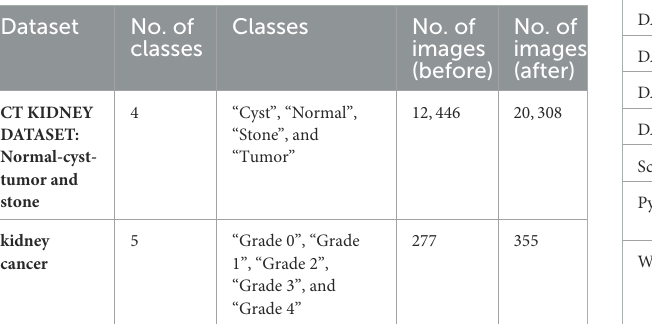
TABLE 5 The used datasets specifications summarization.